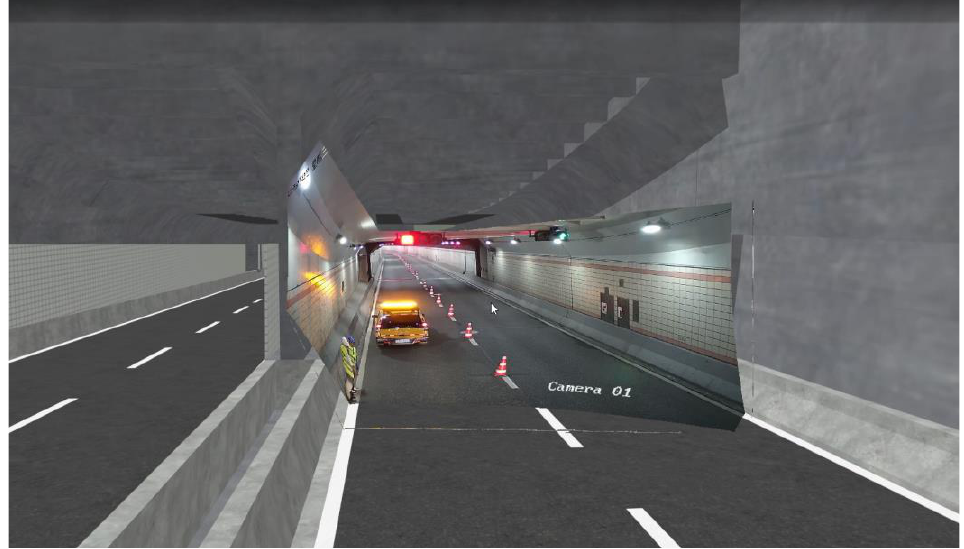
Figure 12. Intelligent patrol of full-line tunnels.